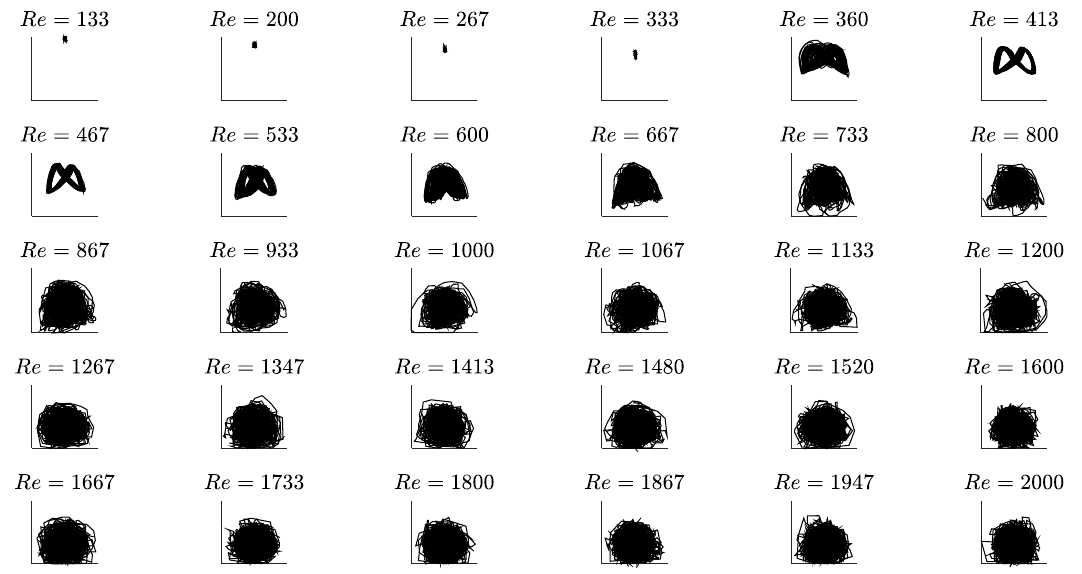
Figure 7. Trajectory of the free-end of Filament 1 as seen by an observer located downstream of the filament and facing the flow (Y-Z plane in Figure 2c).